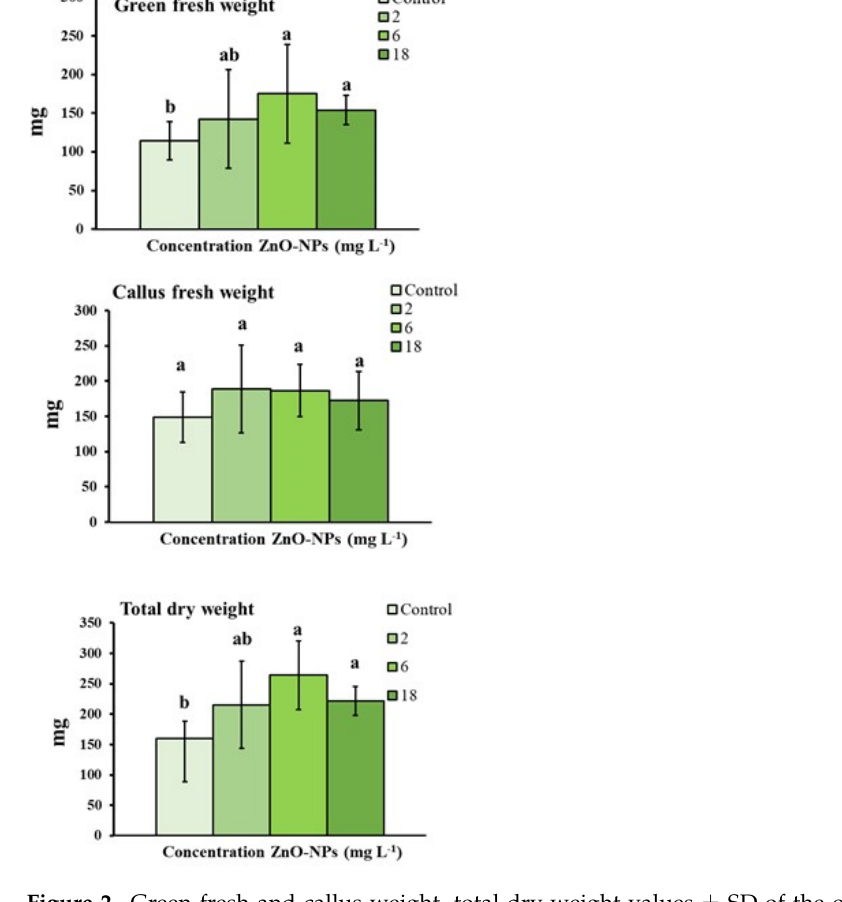
Figure 2. Green fresh and callus weight, total dry weight values ± SD of the olive proliferated explants. Means values followed by different letters were significantly different ( p < 0.05).